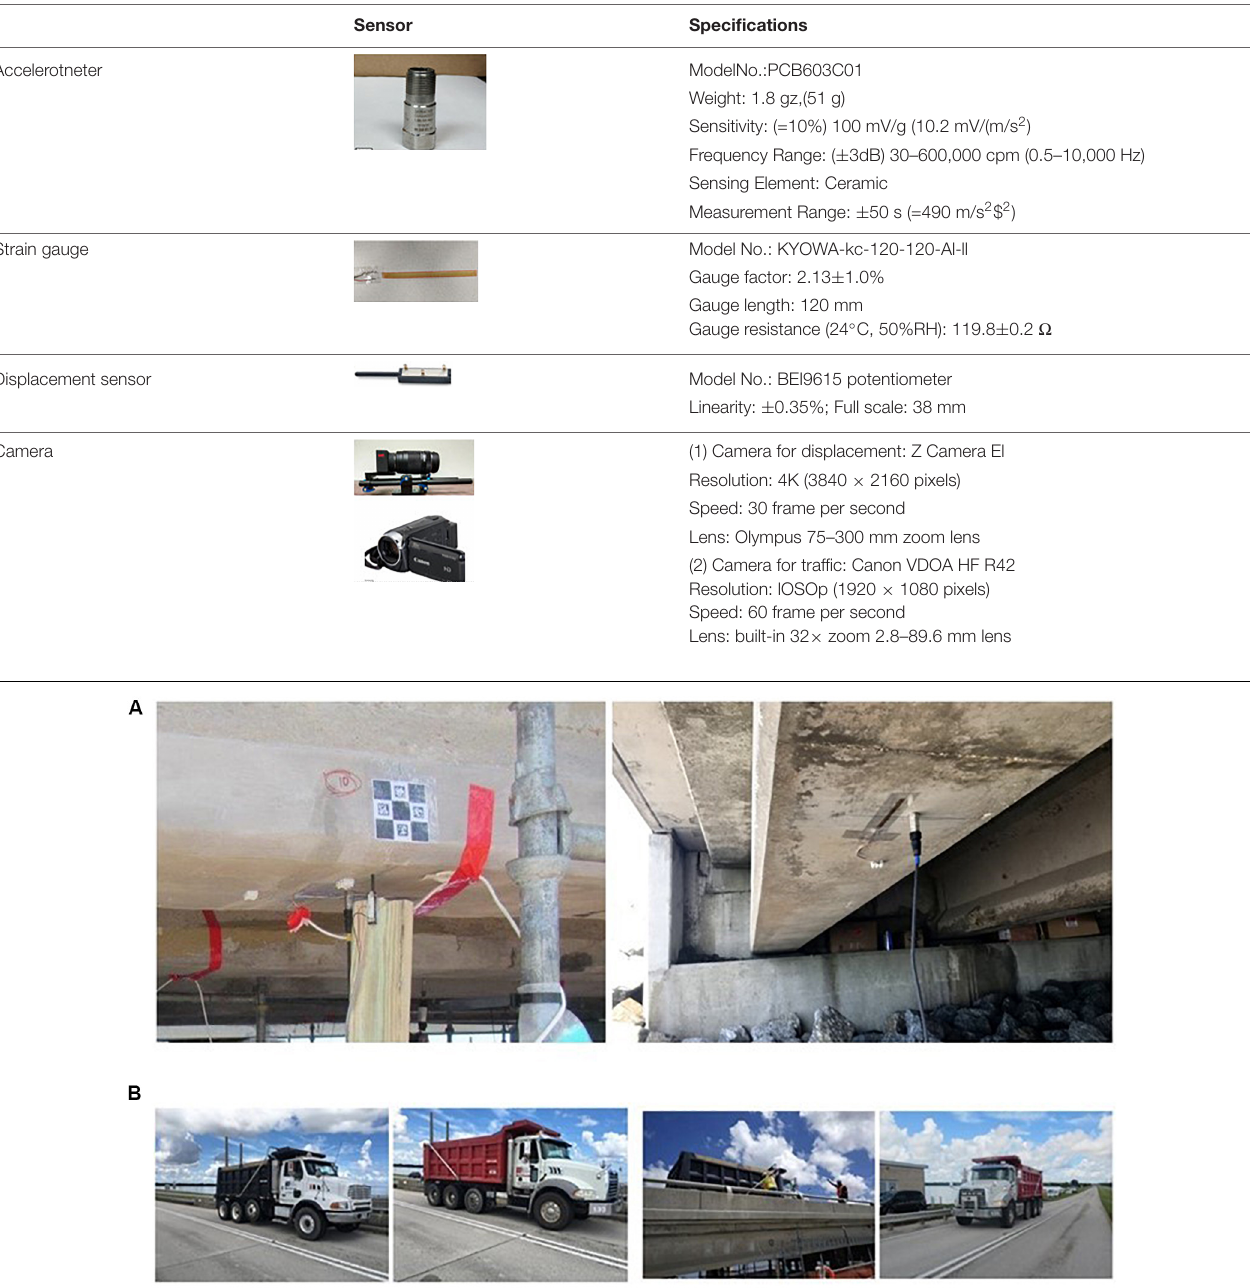
TABLE 1 | Specifications of sensors and cameras.